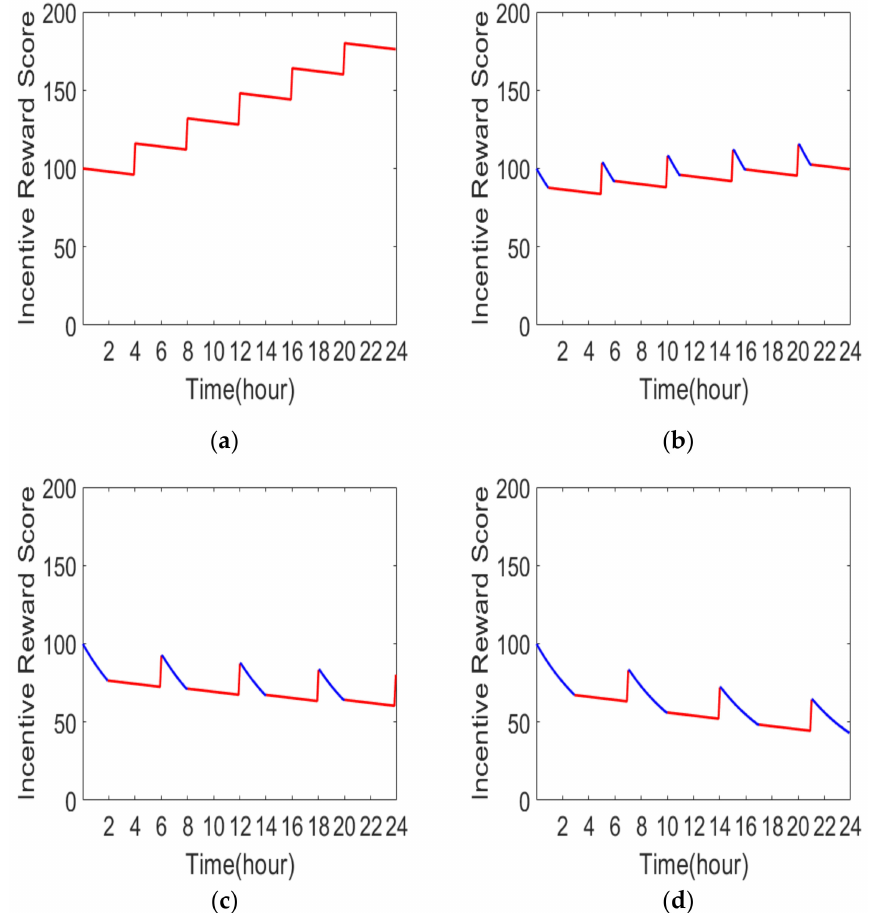
Figure 7. Comparison of incentive score with different negative collaboration time(red: positive, blue: negative): ( a ) Edge devices that continuously collaborate actively; ( b ) Edge devices that passively collaborate for 1 h; ( c ) Edge devices that passively collaborate for 2 h; ( d ) Edge devices that passively collaborate for 3